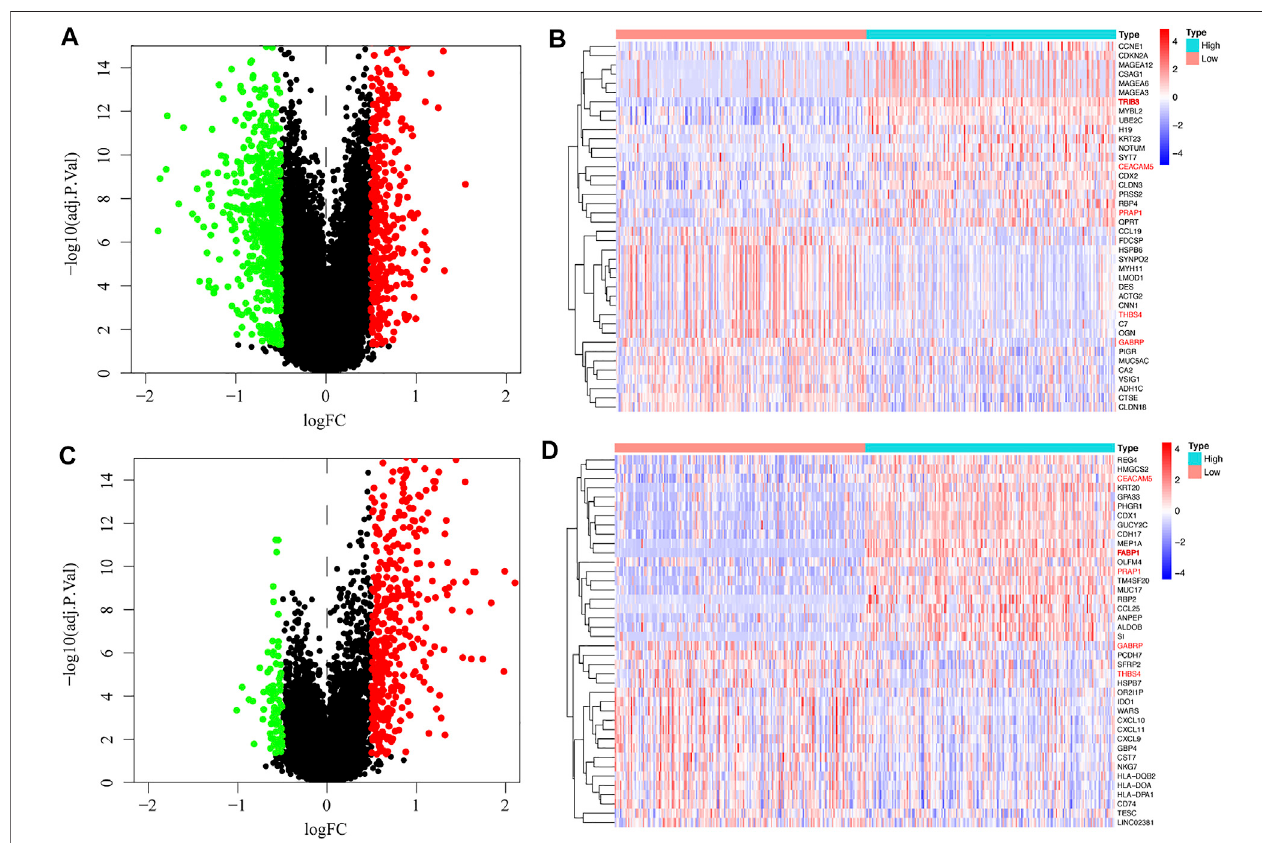
FIGURE6| Genesco-expressedwithTRIB3 (A) andFABP1 (C) weresearched,withthetop20positivelyornegativelyregulatedgenesofTRIB3 (B) orFABP1 (D) visualized by the heat plot.